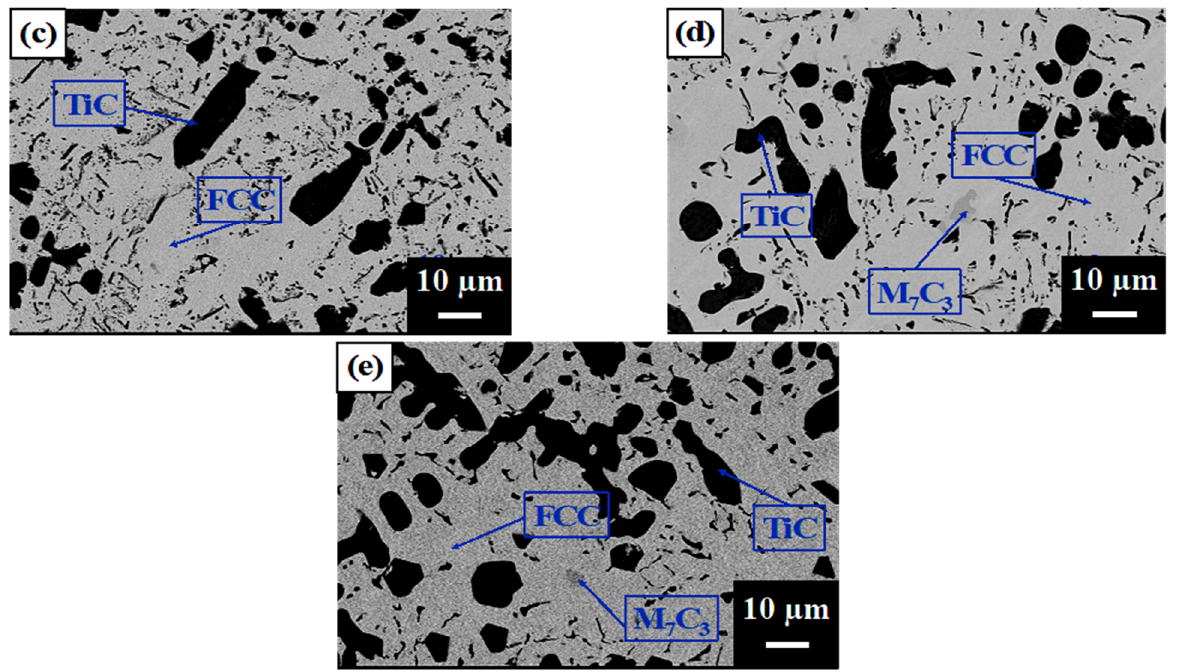
Figure 2. SEM images of the as-cast microstructures of ( a ) A1, ( b ) A2, ( c ) A3, ( d ) A4, and ( e ) A5.